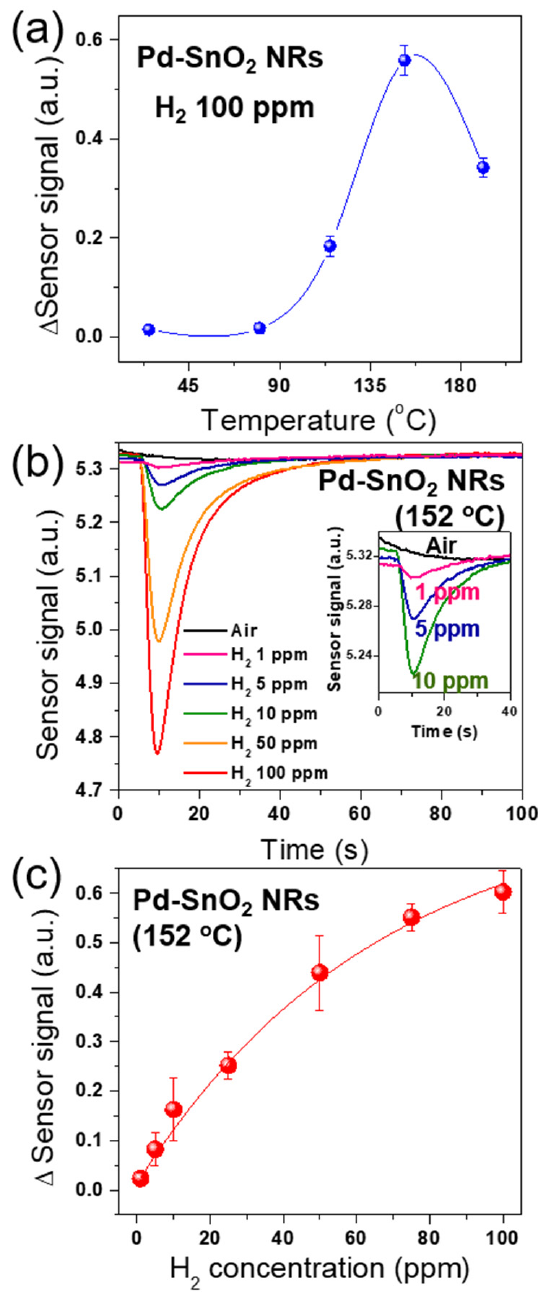
Figure 4. Sensing properties of the Pd-coated SnO 2 NR arrays using the mini-GC: ( a ) sensing response ( ∆ Sensor signal) to 100 ppm hydrogen as a function of operating temperature; ( b ) sensor signals of the Pd-coated SnO 2 NR arrays to various H 2 concentrations (1–100 ppm) at 152 ◦ C (Inset: the cases of low H 2 concentration (1–10 ppm)); ( c ) sensing response as a function of H 2 concentrations at 152 ◦